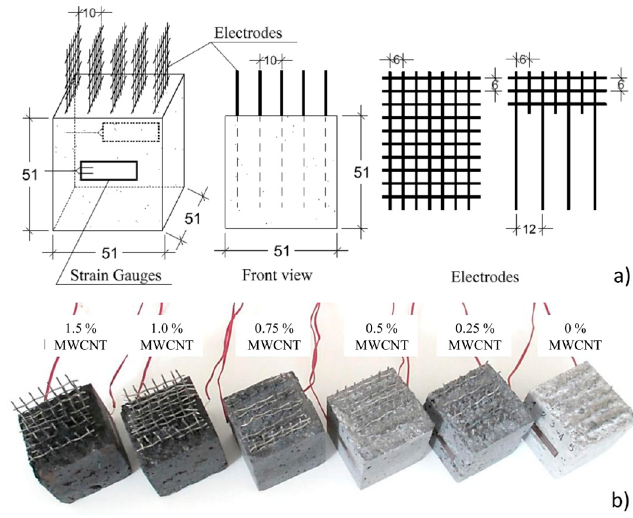
Figure 2. ( a ) Geometry of specimens and electrodes (dimensions are in mm); ( b ) Picture of samples with 1.5, 1.0, 0.75, 0.5, 0.25 and 0% (from left to right) MWCNTs.